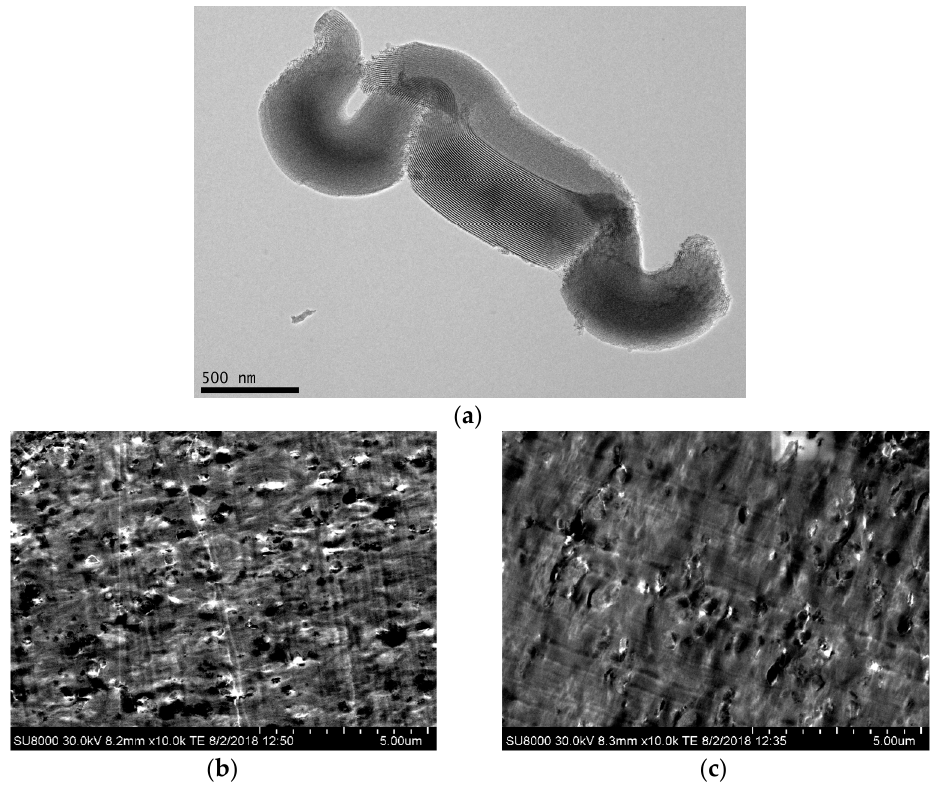
Figure 1. ( a ) TEM micrograph for SBA-15 silica at a scale bar of 500 nm. FESEM images in the two composites: PLLA2SBA8 ( b ) and PLLA4SBA9 ( c ), at a scale bar of 5 µm.